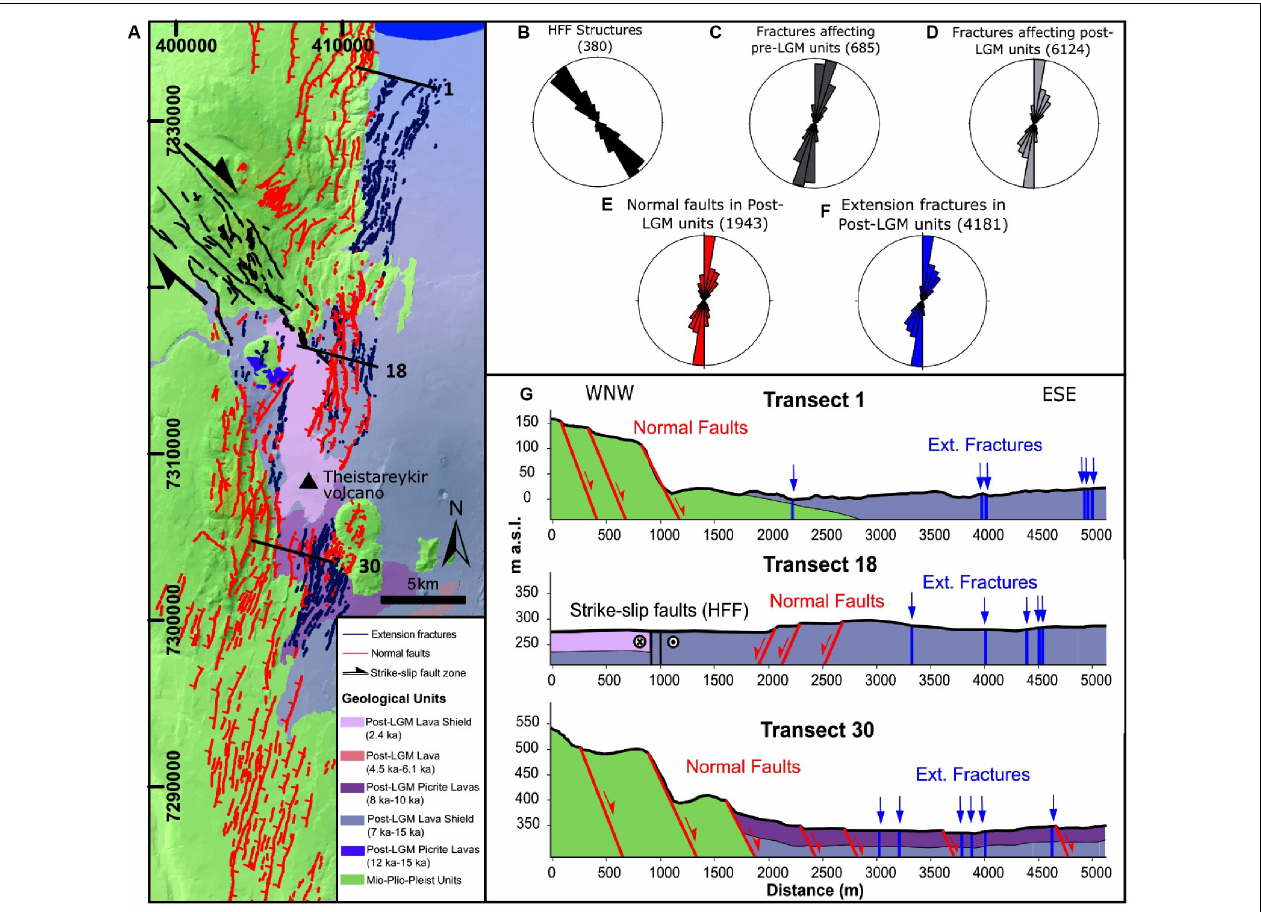
FIGURE 4 | (A) Simplified geological map with indication of normal faults (red), strike-slip faults (black) and extension fractures (blue) identified in the study area. Ticks on downthrown side of normal faults. Geological units after Saemundsson et al. (2012). Spatial reference: WGS 84/UTM zone 38N. Rose diagrams show: (B) the strike of all the strike-slip segments belonging to the Husavik-Flatey Fault (HFF), (C) the strike of all structures affecting pre-LGM units, (D) the strike of all structures affecting post-LGM units, (E) the strike of faults only affecting post-LGM units, and (F) the strike of extension fractures only affecting post-LGM units. (G) Geological-structural sections following parts of transects 1, 17, and 30 of Figure 8 , the exact traces of sections are represented in Figure 4A , geological units as in Figure 4A .